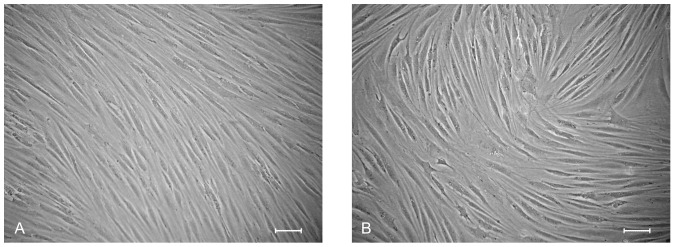
The cell morphology of vocal fold fibroblasts (VFFs).(A) and differentiated adipose-derived mesenchymal stem cells (dADSCs) (B). Both showed a spindle shape. Scale bar  =  100μm.